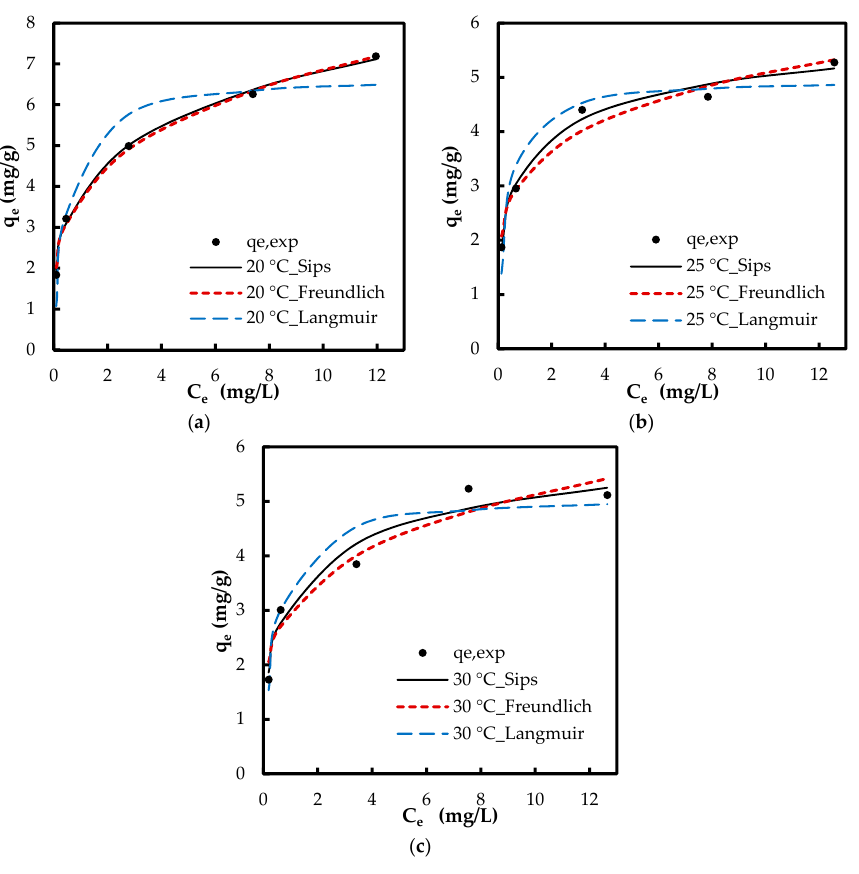
Figure 10. Experimental q e (markers) and theoretical q e (lines) via nonlinear regression of isotherm models at: ( a ) 20 °C; ( b ) 25 °C; and ( c ) 30 °C.